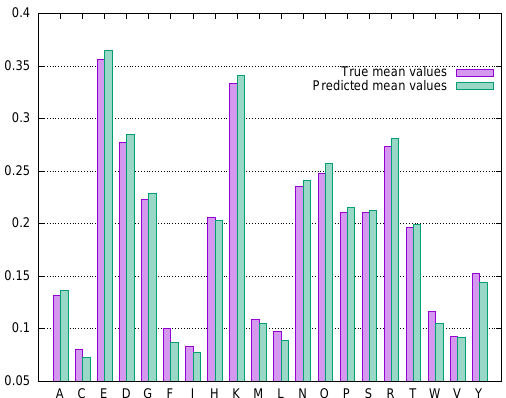
Figure 3. Comparison of true mean values and predicted mean values for 20 types of amino acids using the CB502